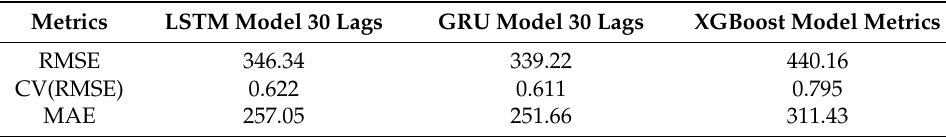
Table 3. Performance Metrics Comparison of single sequence models.